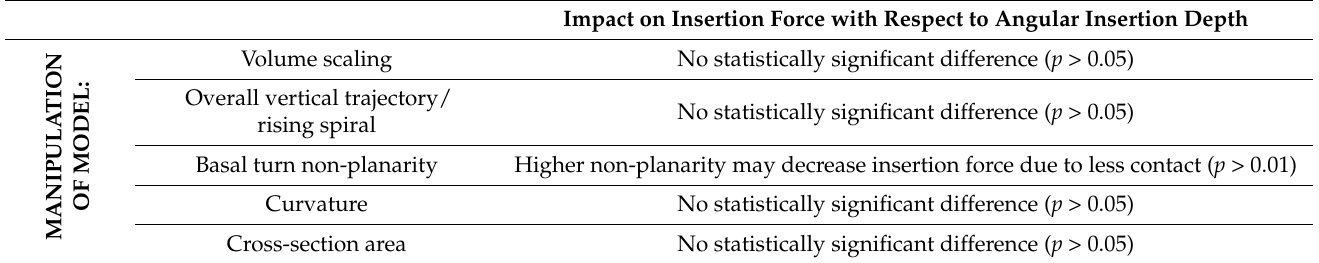
Table 2. Summary of the effect of ST shape manipulation on cochlear insertion forces. Impact on Insertion Force with Respect to Angular Insertion Depth